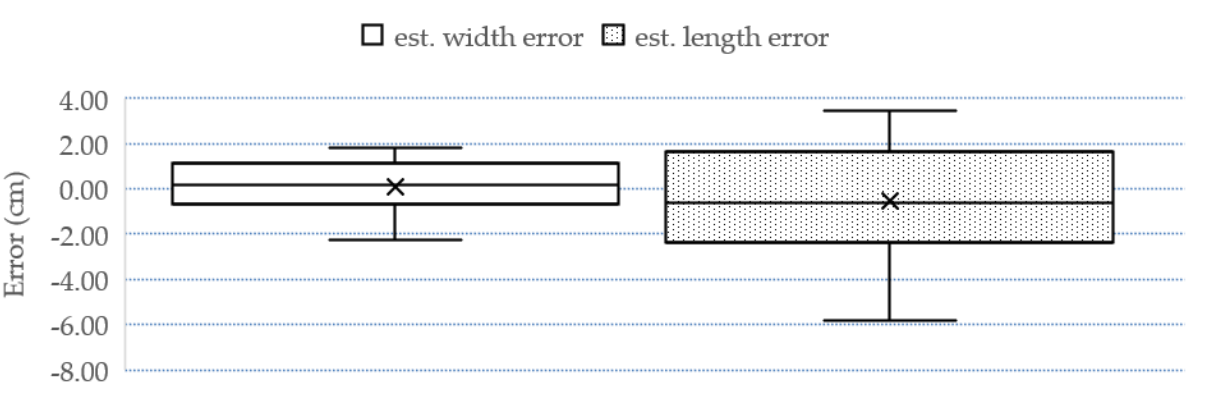
Figure 15. Examples of Tilapia Weight-Estimation Results in turbid water for two cases that are near and far from camera: (1) the near camera: a single fish and two overlapping ( top and down left ) and (2) the far from camera: a single fish and two overlapping ( top and down right ).